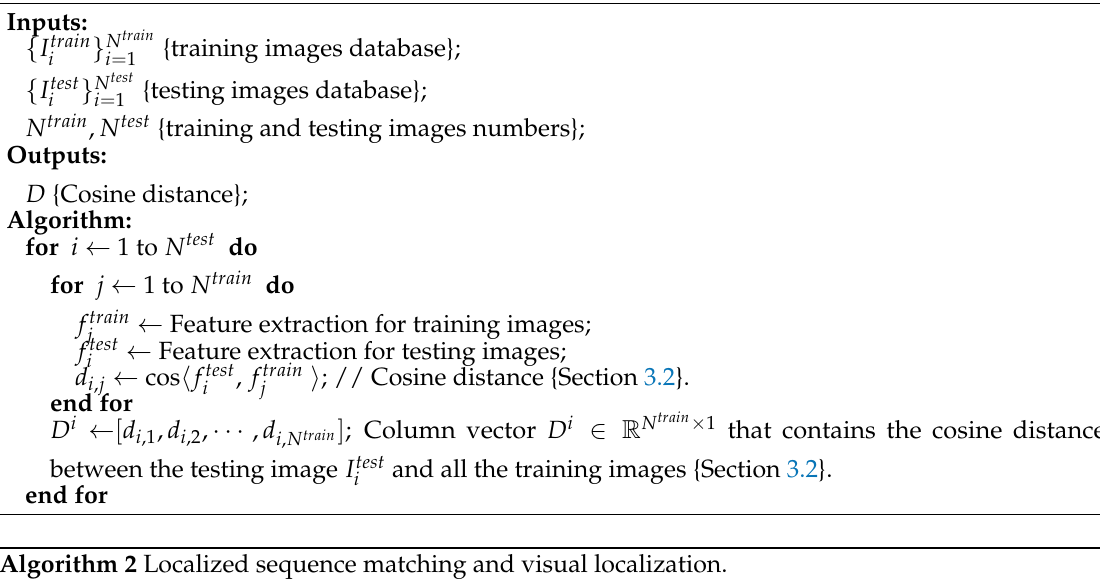
Algorithm 1 ConvNet feature extraction and comparison.